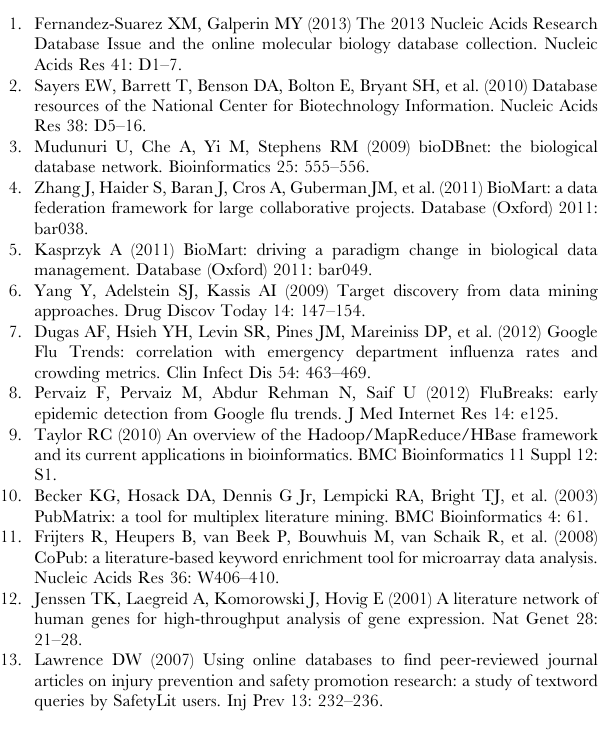
Table S1 Cancer term occurrences in the literature. A three column tabular representation with cancer terms, number of publications and the PubMed ID’s of articles containing the cancer term. Table S2 Gene occurrences in the literature. A three column tabular representation with genes, number of publications and the PubMed ID’s of articles containing the gene term. Table S3 miRNA occurrences in the literature. A three column tabular representation with miRNAs, number of publica- tions and the PubMed ID’s of articles containing the miRNA term. Table S4 Gene-Cancer Co-occurrences in the literature. A four column tabular representation with genes, cancer terms, number of publications and the PubMed ID’s of articles containing both the gene and cancer terms. Table S5 miRNA-Cancer Co-occurrences in the litera- ture. A four column tabular representation with miRNAs,